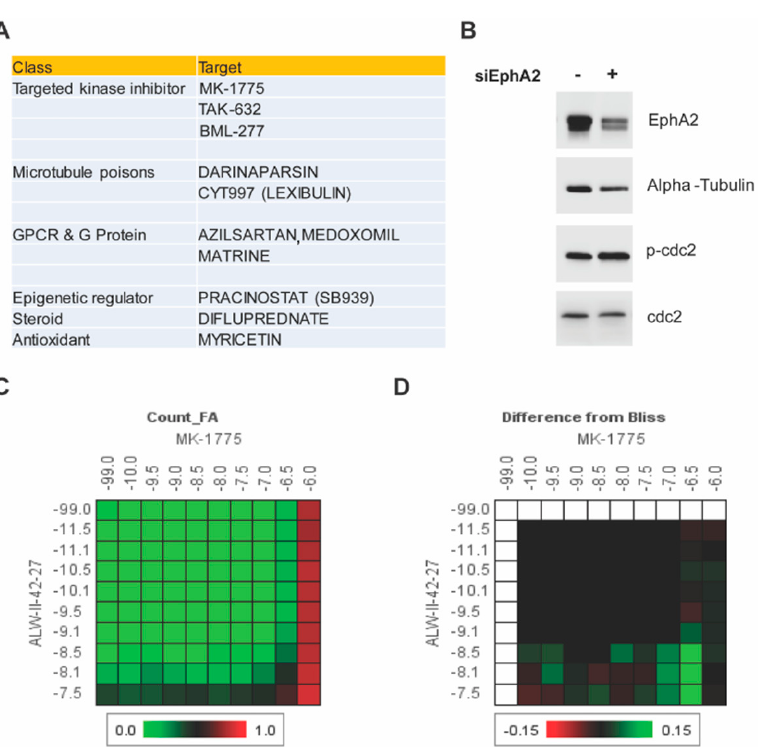
Figure 1. High–throughput screen for synergistic partners for EphA2–targeted therapy and verifi- cation of Wee1 as a target. ( A ) Top 10 hits from the chemical screen. ( B ) Effect of EphA2 silencing on Wee1 activity, as seen by phosphorylation of cdc2, in Hec1A cells. ( C ) Dose–response matrix for combinatorial analysis of the EphA2 inhibitor ALW and Wee1 inhibitor MK1775. ( D ) Difference from predicted Bliss independence surface model for the combination of ALW and MK1775. ( E ) Visualization of the calculated 2D synergy maps for the MTT cell viability assay from the Syner- gyFinder Bliss independence model combinatorial analysis. Red regions represent synergy, and green regions represent antagonism. ( F ) Plots showing fraction of cells affected (Fa) and combina- tion index (CI) values for ALW and MK1775. The white circles representing the CI values of the ALW:MK1775 combination (1 µM:0.5 µM and 1 µM:0.75 µM concentrations, respectively) were less than one, indicating synergy. 2.2. MK1775 Sensitizes Endometrial Cancer Cells to EphA2 Inhibition Upon morphological analyses, single-drug-treated wells showed a lower number of cells in comparison to control cells, and the cell numbers were even lower with the com- bination treatment (Figure 2A). Of interest here is the appearance of many round cells for the ALW and MK1775 combination treatment at both the 24 h and 48 h time points, which could be either cells undergoing mitosis or cells preparing to die by apoptosis. To under- stand this, we performed cell cycle analysis and observed that there was a decrease in number of cells in the G1 phase and a concomitant increase in number of cells in the S phase for the combination treatment at the 48 h time point (Figures 2B and S1C,D). In addition, there was a statistically significant increase in the sub-G1 population in cells